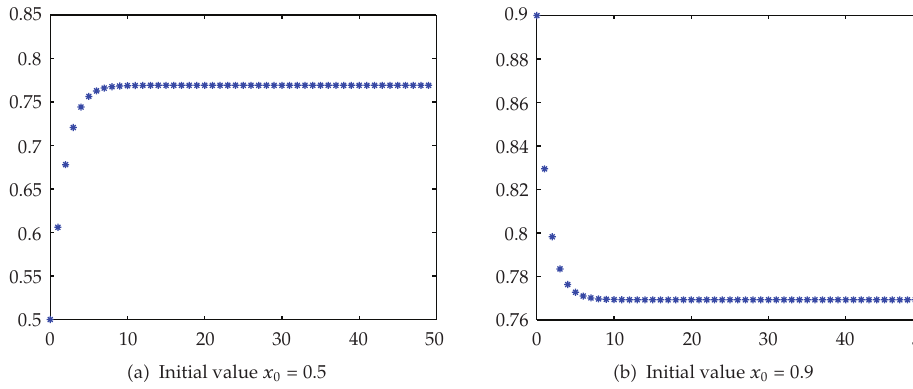
Figure 2: r (cid:5) 2, q (cid:5) 1; x ∗ (cid:5) 10 / 13 ≈ 0 .